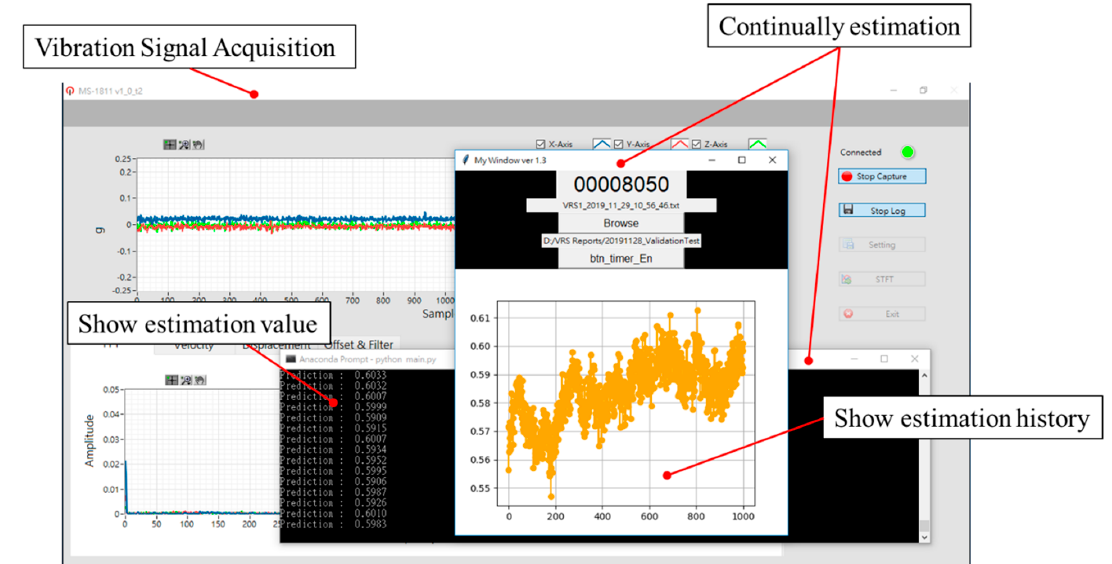
Figure 19. The continuous monitoring user interface program.